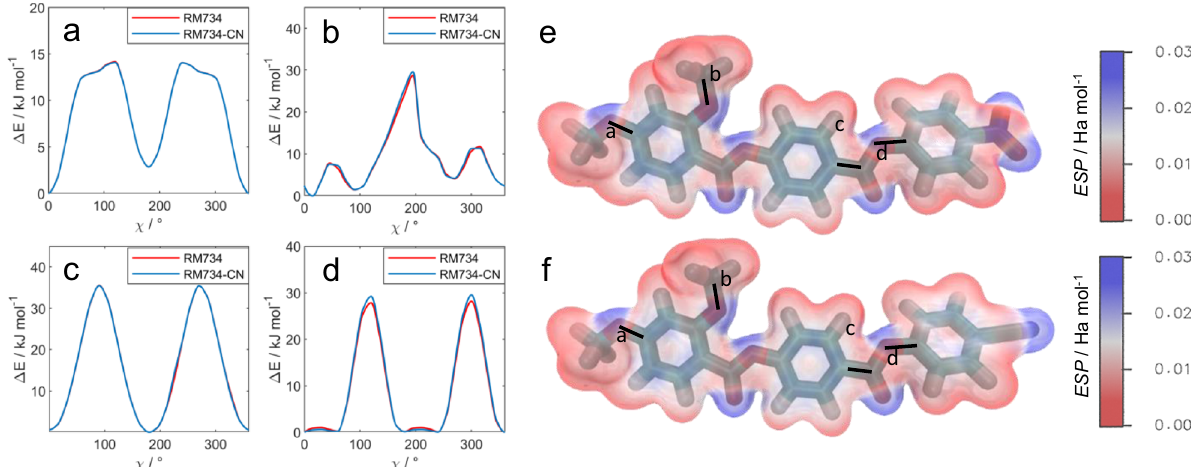
Fig. 4 DFT conformational investigations. a – d Conformational energy as a function of the rotational angle for the labelled bonds of RM734 (red solid lines) and RM734-CN (blue solid lines). Minimum energy geometries of RM734 ( e ) and RM734-CN ( f ), each with the electrostatic potential isosurface (isovalue 0.04). All calculations were performed at the M06HF-D3/aug-cc-pVTZ level of DFT, as implemented in Gaussian G09